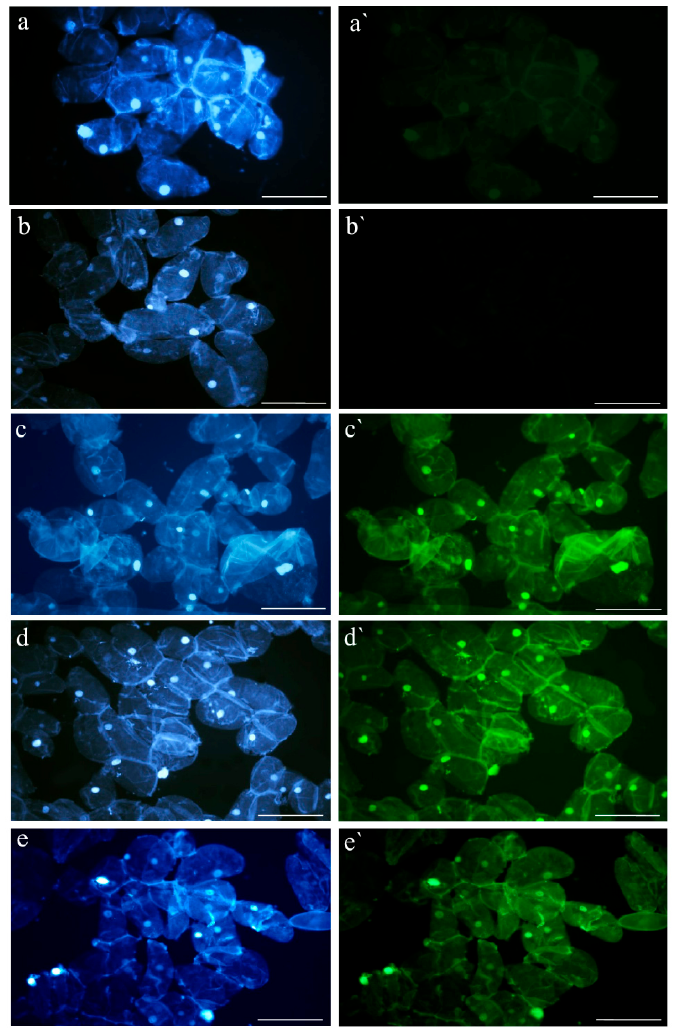
Figure 3. In situ detection of DNA fragmentation in the Brachypodium callus cells on the 14th day of the culture using the TUNEL assay. Blue fluorescence: DAPI staining ( a – e ), green fluorescence: FITC marking TUNEL-positive nuclei ( a` – e` ). ( a , a` ) control callus; ( b , b` ) negative control in TUNEL reaction; ( c , c` ) positive control in TUNEL reaction; ( d , d` ) callus that has been treated with 5 µM of 5-azaC; ( e , e` ) callus that has been treated with 50 µM of 5-azaC. Scale bars, 50 µm.